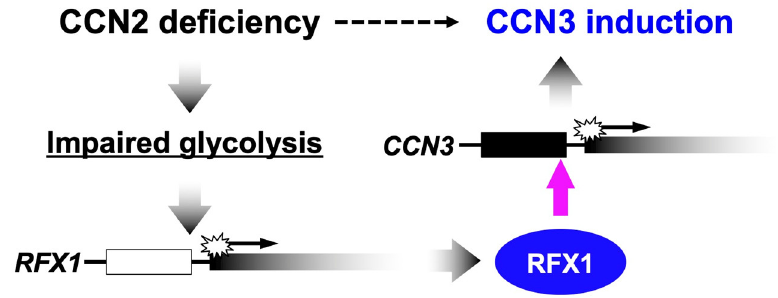
Figure 2. Mechanism of the negative regulation of CCN3 by CCN2 in chondrocytes. A transcriptional factor regulatory factor binding to the X-box (RFX1) mediates this metabolic gene regulation.